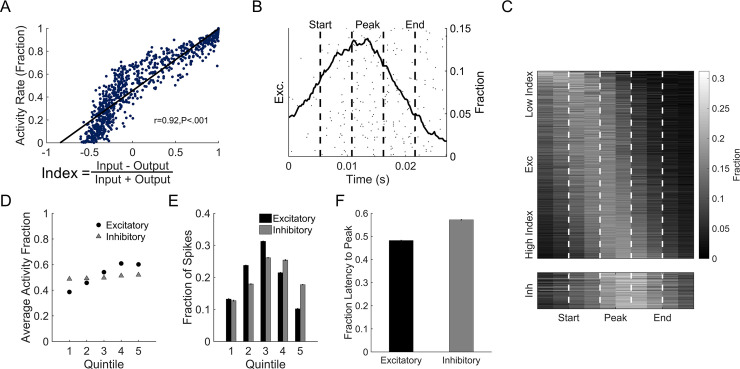
Activity-dependent functional roles of neurons.(A) After initial settling, networks developed structure-function relationships. We defined the neuron-connectivity index as the difference between input and output strengths normalized to total strength. Firing rate was significantly correlated with neuron-connectivity index. (B) To test the roles of neurons with different activity profiles in oscillations, we divided each oscillation into equal quintiles centered around the peak activation period. The labels and dashed lines correspond to those in panel C. We then tracked when each neuron fired within the oscillation. (C) Low index neurons tended to fire early in network oscillations, suggesting a role in oscillation initiation. High index neurons conversely fired at the peak of the oscillation and activated downstream inhibitory circuitry to stop oscillatory behavior. (D) Low activity excitatory neurons were more likely to be active early in oscillations. Later stages showed increased activation of highly active excitatory neurons. Inhibitory neurons showed no activity dependence in their firing time within oscillations. (E-F) Excitatory neurons had increased activation to peak oscillation magnitude, with decreasing activation after the peak. Inhibitory neurons had delayed activation, primarily firing at peak or late in the oscillation.